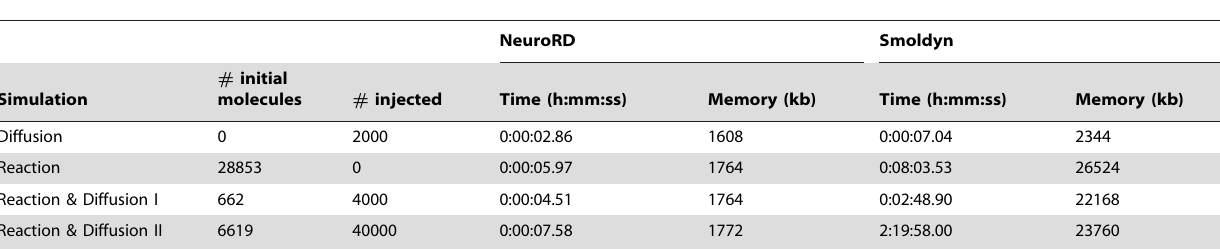
Table 3. Comparison of scalability between NeuroRD and Smoldyn.